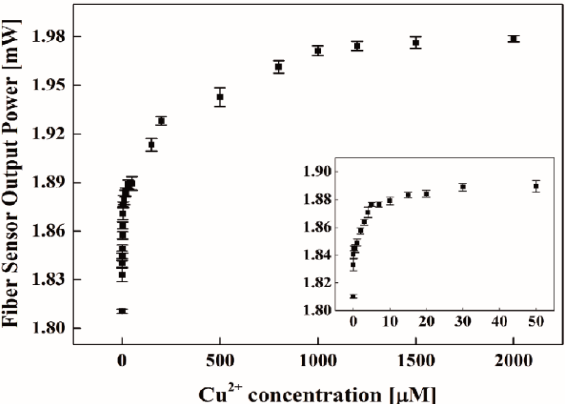
Figure 7. The fiber sensor device output power vs. Cu 2+ concentrations (0 to 2 mM) with APTES/chitosan-EDTA functionalization on the surface.